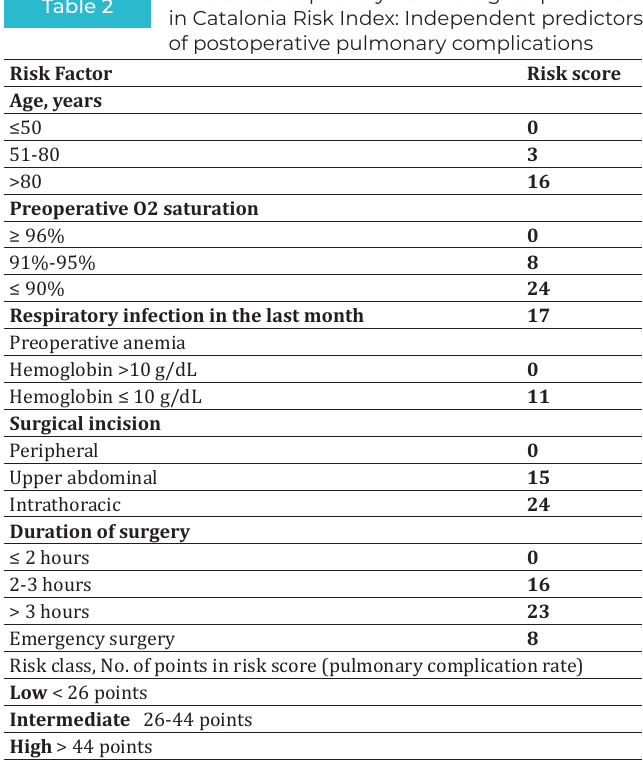
The assess respiratory risk in surgical patients in Catalonia Risk Index: Independent predictors of postoperative pulmonary